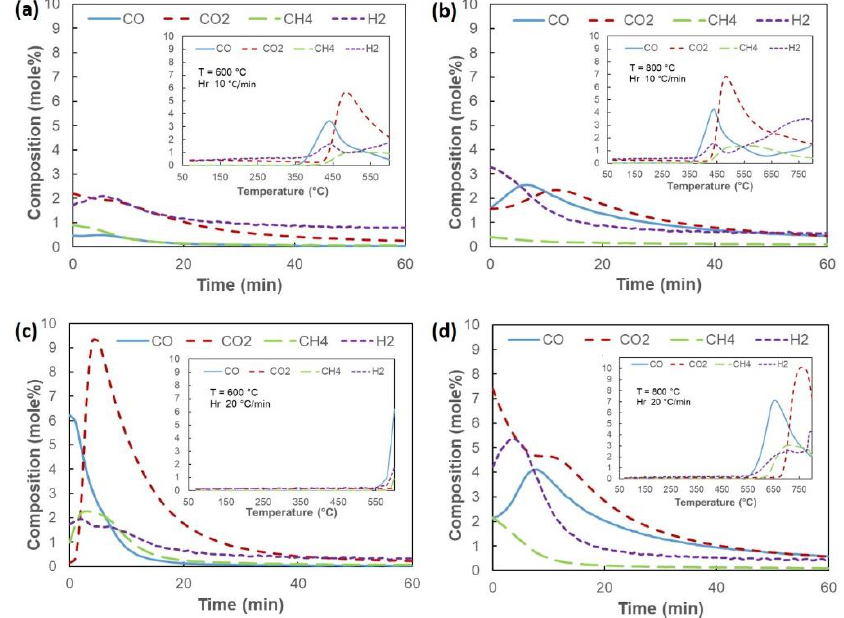
Figure 8. The temperature and heating rate effects on gas composition when the temperature rises (small graphs) and the isothermal reduction lasting 60 min for a heating rate of 10 ◦ C/min ( a , b ) and 20 ◦ C/min ( c , d